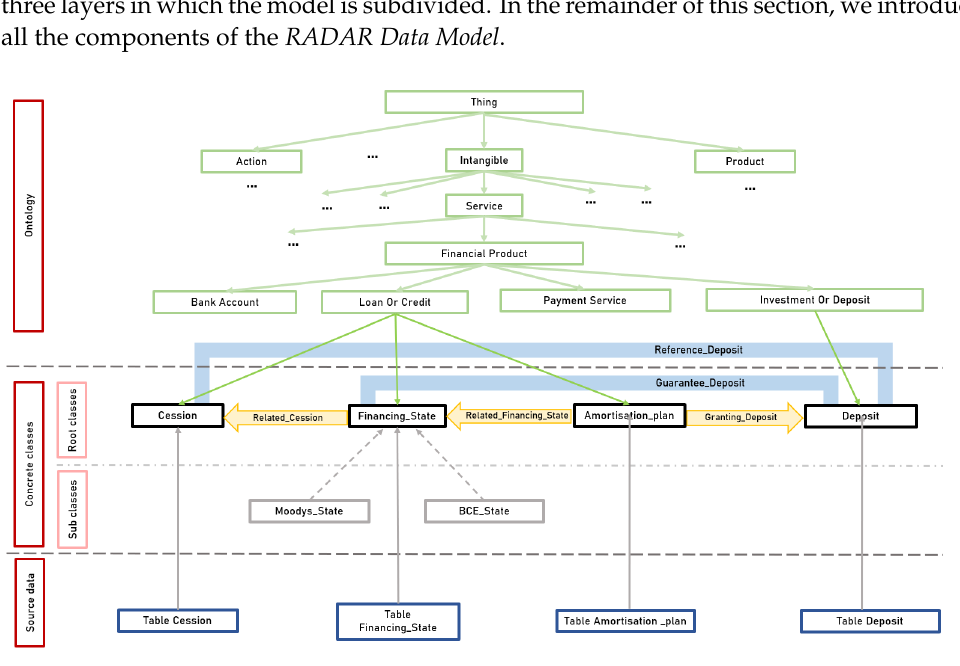
Figure 2. Graphical representation of the unified view of ontology ( top ), high-level logical model ( middle ) and source tables ( bottom ) for the running